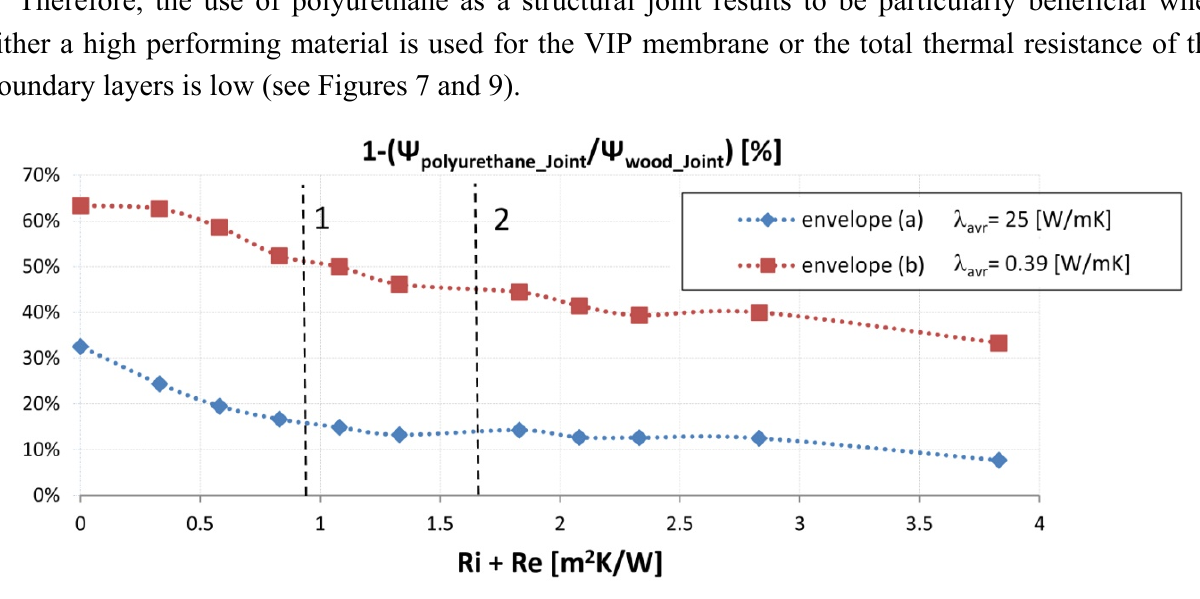
Figure 9. Difference between ψ values for wood and polyurethane joints considering (a) and (b) envelopes (1000 mm × 600 mm VIP